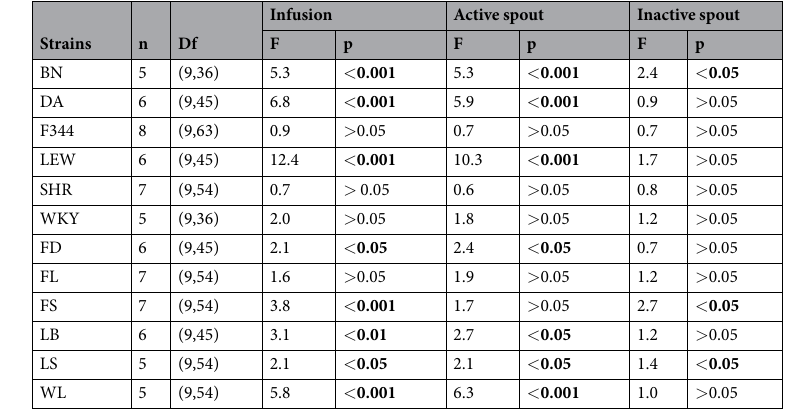
Table 2. Statistical analysis of self-administration data: IIa. Session effect, 15 μ g/kg/inf nicotine. Two-way repeated measures ANOVA was used to analyze the effect of session of the number of nicotine infusions and licks on the active or the inactive spout.